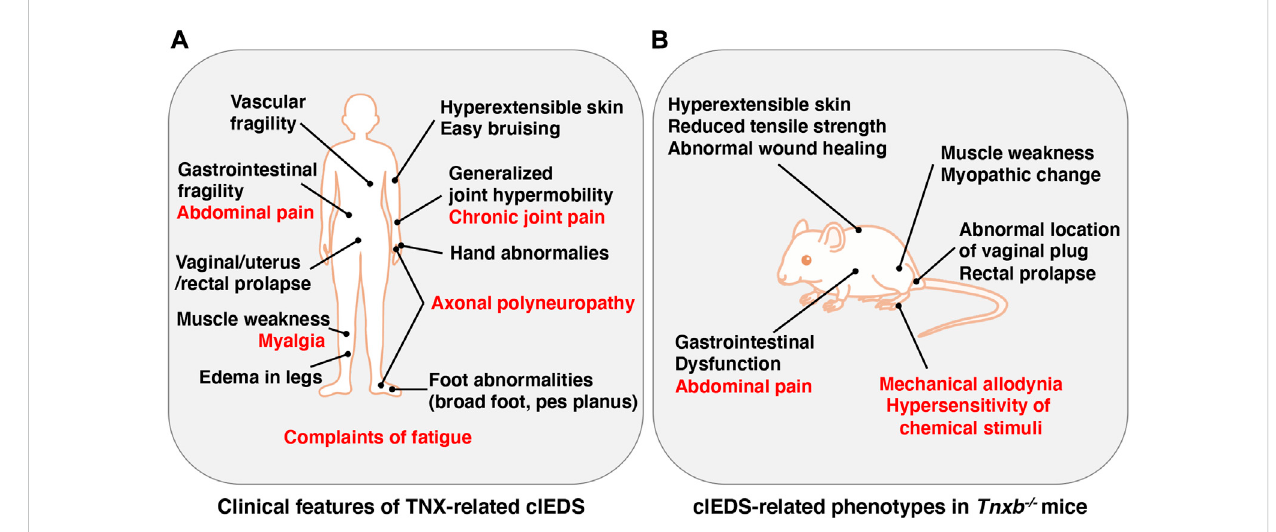
ClinicalfeaturesofTNX - relatedclEDS (A) andclEDS-relatedphenotypesof Tnxb − / − mice (B) .SymptomsinmanypatientswithTNX - relatedclEDSare shown in (A) (van Dijk et al., 2022). Major clEDS-related phenotypes exhibited in Tnxb − / − mice are shown in (B) (Matsumoto and Aoki, 2020). Complaints associated with pain are highlighted by red letters in (A) and (B)